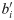
The noisy button model of an interface.An intended input bi′ is flipped with probability f0 or f1, depending on which button was pressed, resulting in the detected input bi.